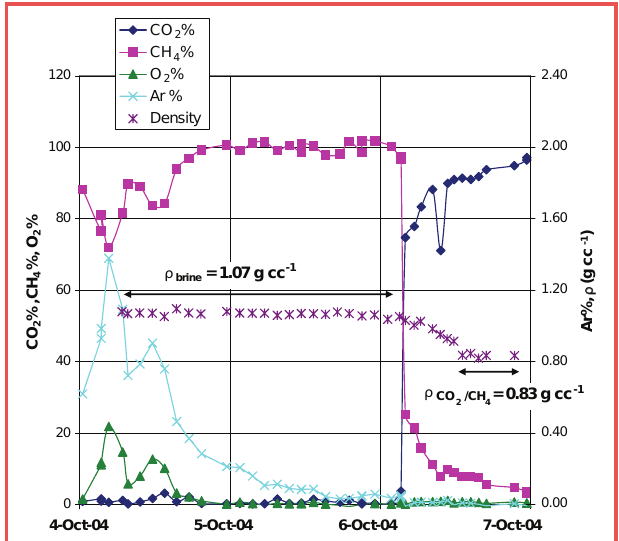
Figure 3. Frio Brine Pilot geofluid sample gas composition and density. Note that the presence of oxygen is indicative of atmospherically contaminated well-workover